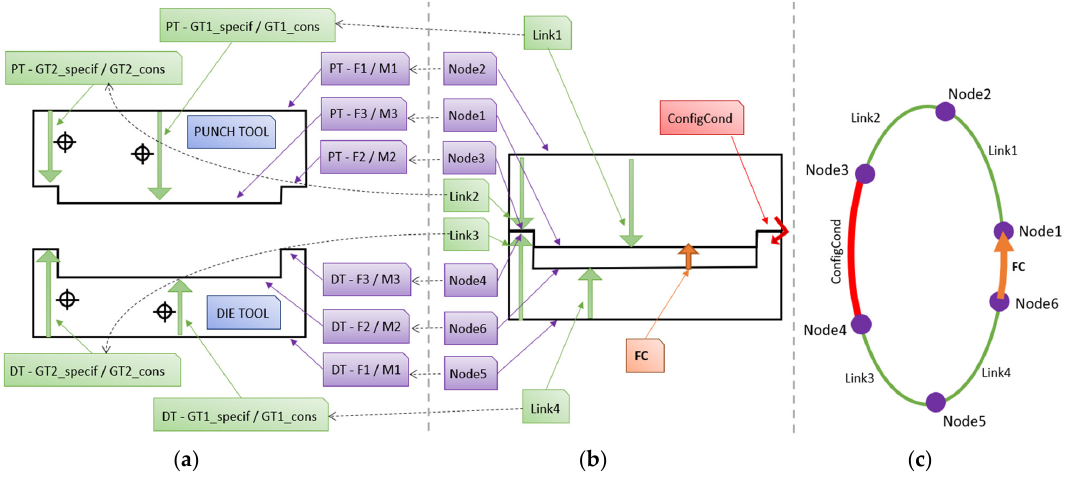
Figure 20. Graphical representation of the tolerance analysis developed: ( a ) elements involved in the analysis, ( b ) additional constraint and Functional Condition definition, ( c ) Functional Chain to be analyzed.